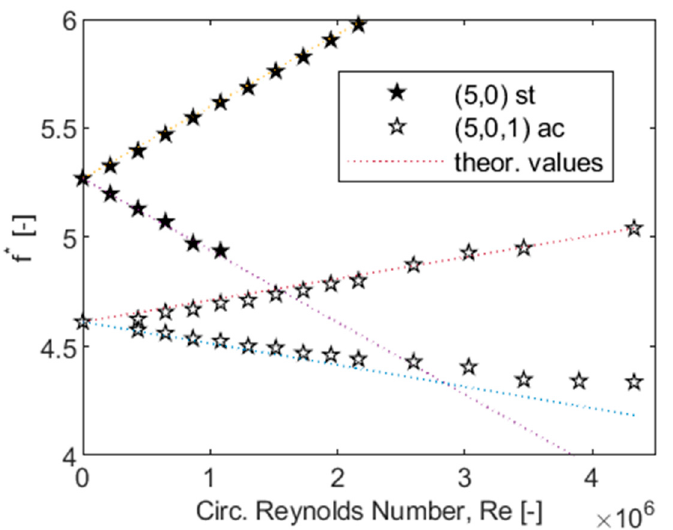
Figure 12. Normalized natural frequencies of five nodal diameter mode pair in air at 0.1 MPa for “slim cavity” over circumferential Reynolds number. Experimental and theoretical results (a core rotation factor of 0.30 is adopted for the theoretic values of the acoustic wave).